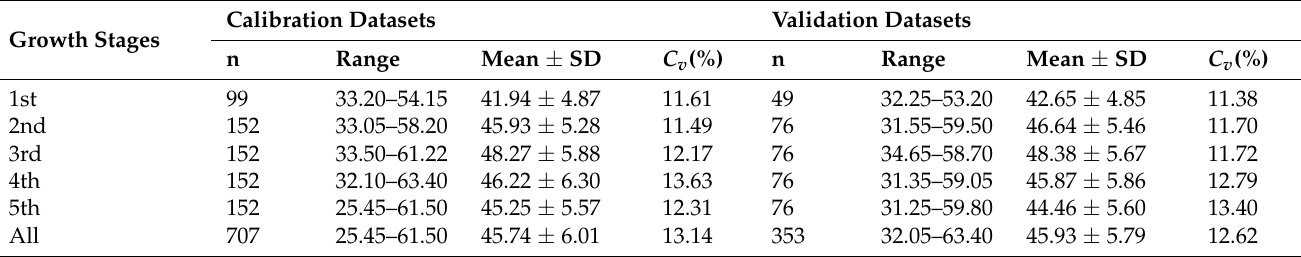
Table 3. Summary of LCC measurements for each growth